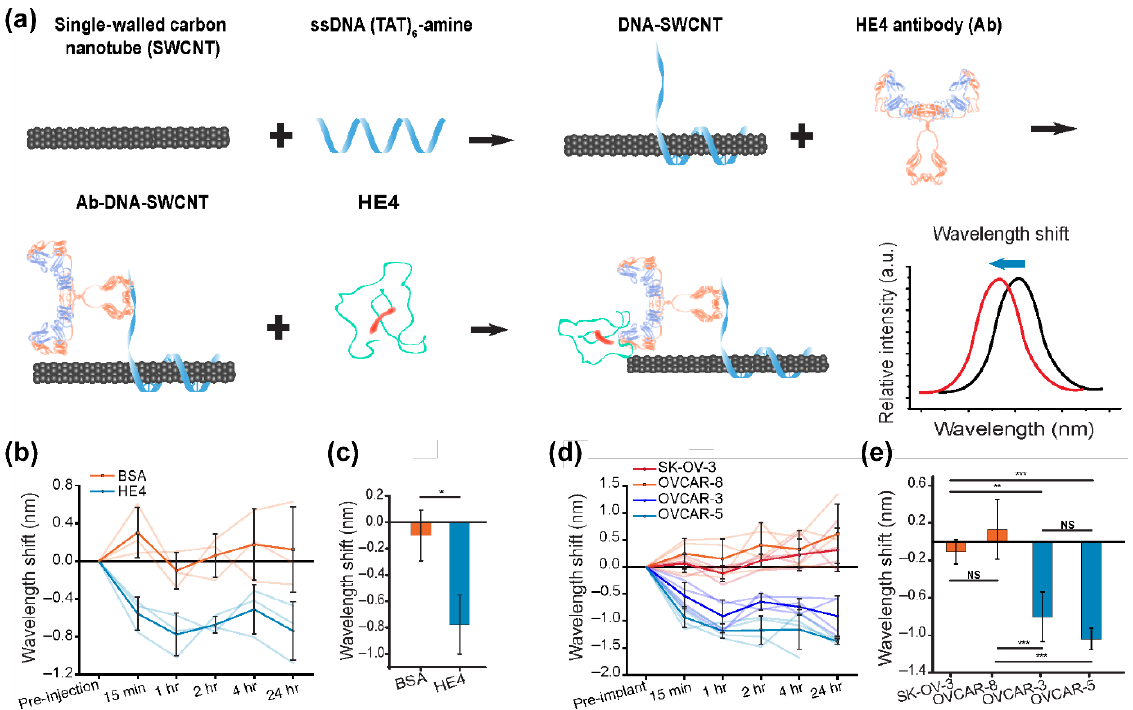
Figure 4. Optically responsive carbon nanotubes sensors sensitive to HE4 biomarker by Williams et al. [83]. ( a ) Single-walled carbon nanotubes were functionalized with DNA and subsequently a HE4 antibody, whereby binding of the complementary antigen would generate a measurable emission wavelength shift. ( b ) Following intraperitoneal implantation of the sensor, emission center wavelength shifts could be detected following IP injections of 10 pmol HE4 and BSA. ( c ) The emission center wavelength shifts 60 min following intraperitoneal HE4 or BSA injected mice compared to control mice ( n = 3, mean ± SD, * p = 0.016, ** p < 0.01, *** p < 0.001, two-sided t -test). ( d ) Variation in sensor emission following implantation in orthotopic tumor bearing mice bearing mice. Sensor showed significant emission blueshift in tumors expressing HE4 (OVCAR-3 and OVCAR-5). ( e ) The emission center wavelength shifts 60 min following sensor implantation in orthotopic tumor bearing mice.